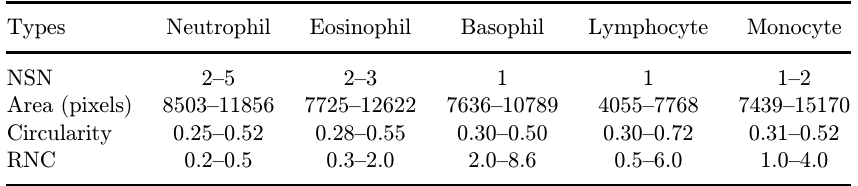
Table 3. Common geometric features of WBC.